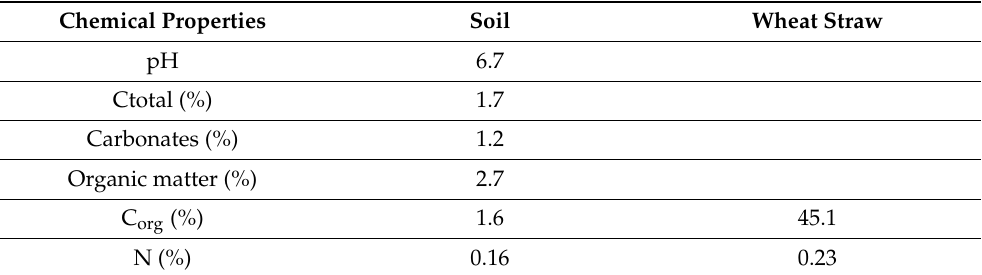
Table 1. Chemical properties of soil and wheat straw used in the